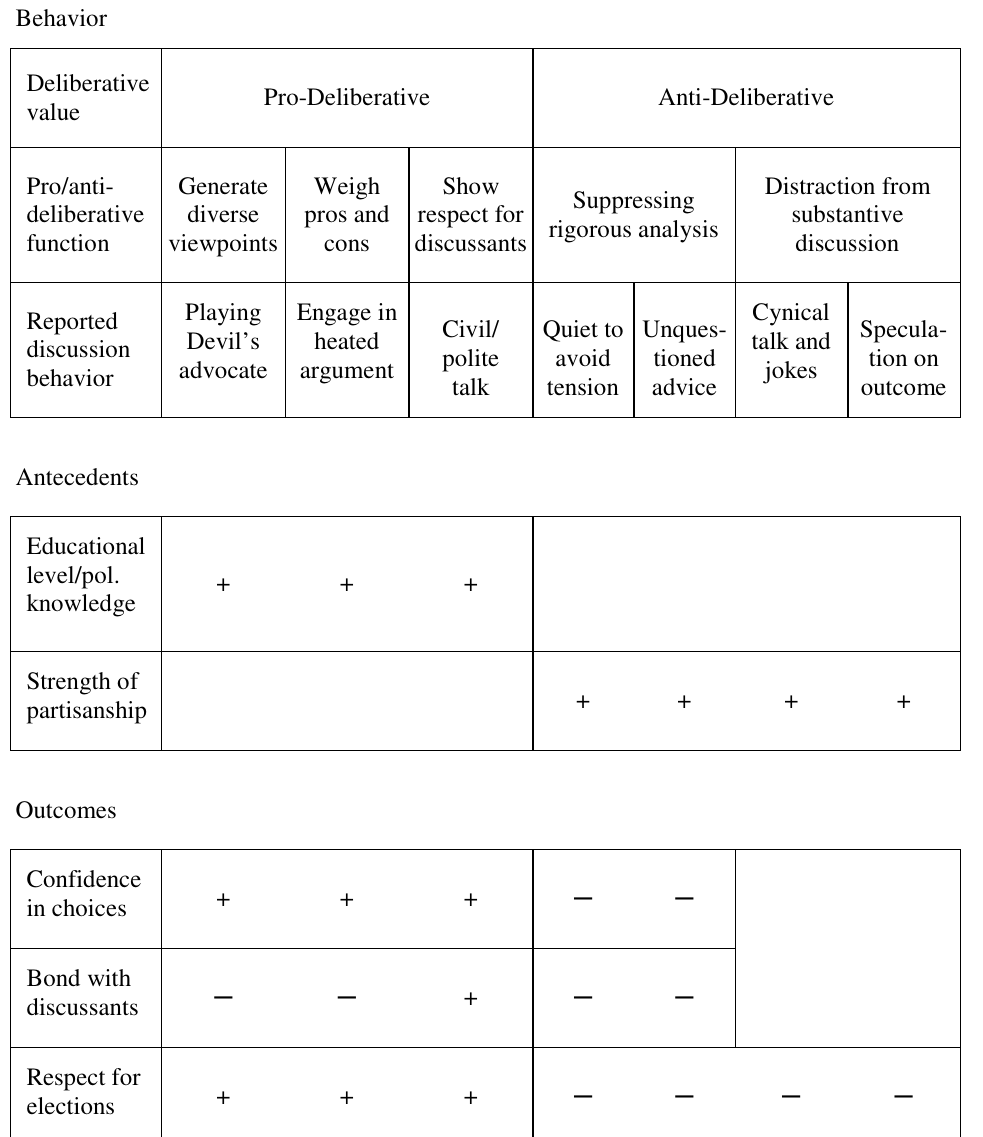
Table 1 Summary of hypothesized relationships among antecedents, discussion behaviors, and